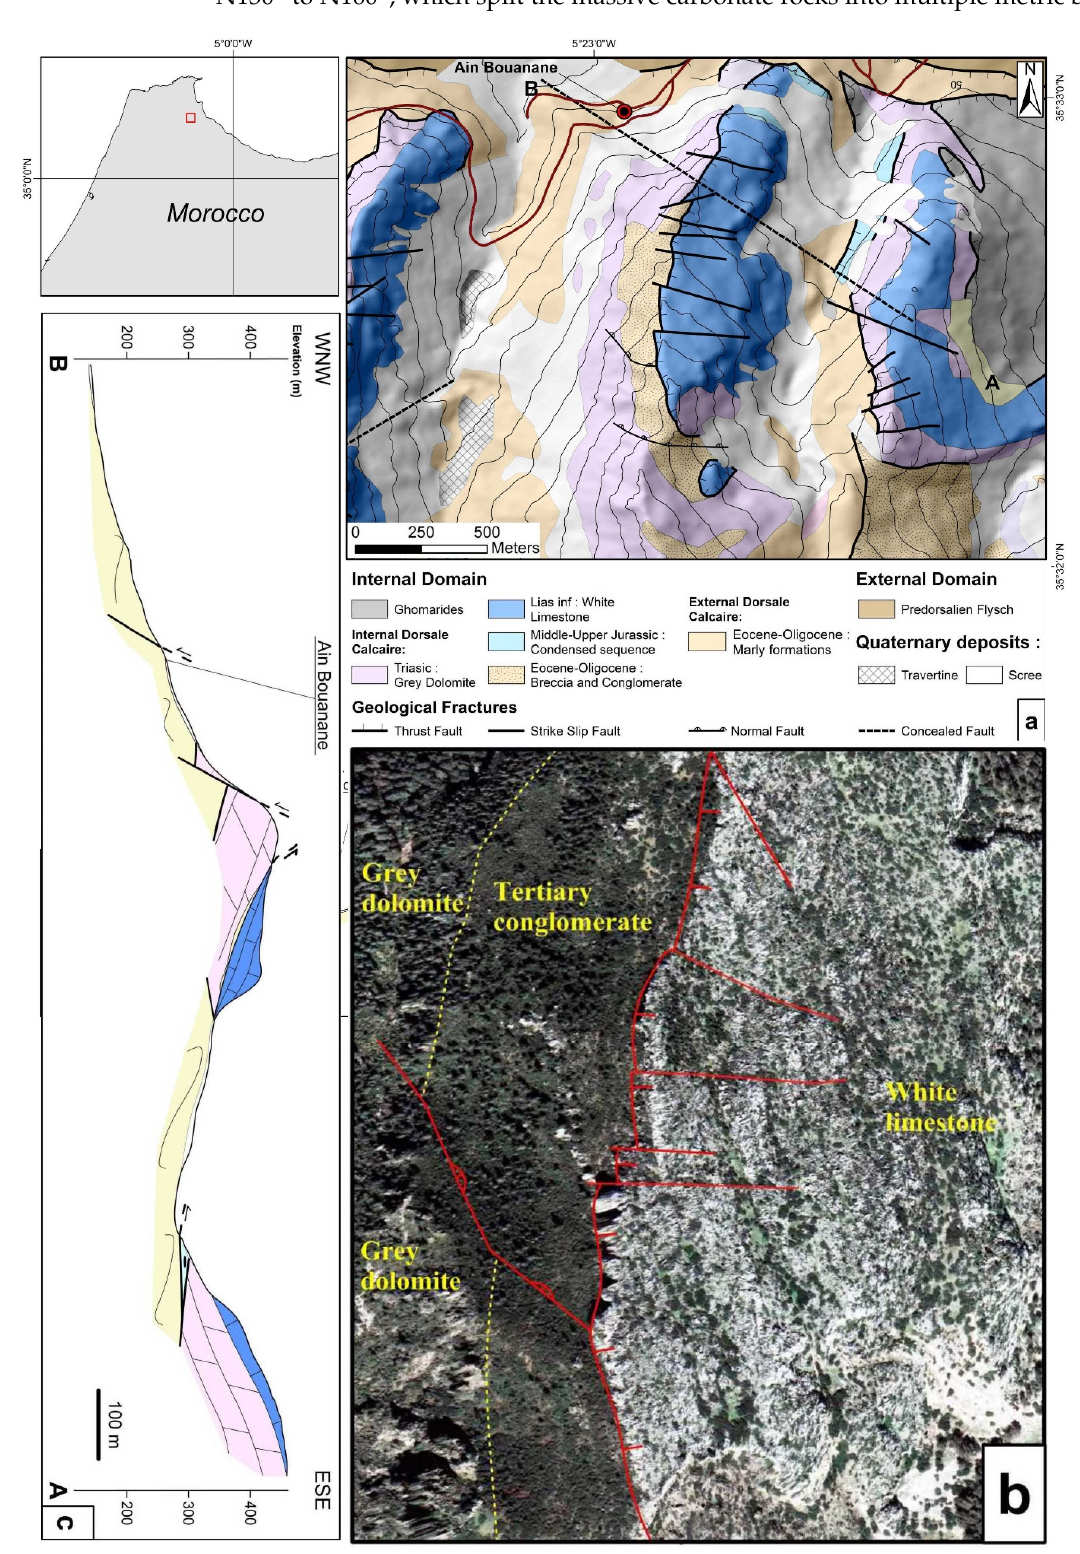
Figure 1. ( a ) Geological map of the study area. ( b ) Aerial photographs showing strike-slip faults affecting the Bouanane massif. ( c ) Geological cross section of the Dorsale Calcaire thrust sheets south of Tetouan.